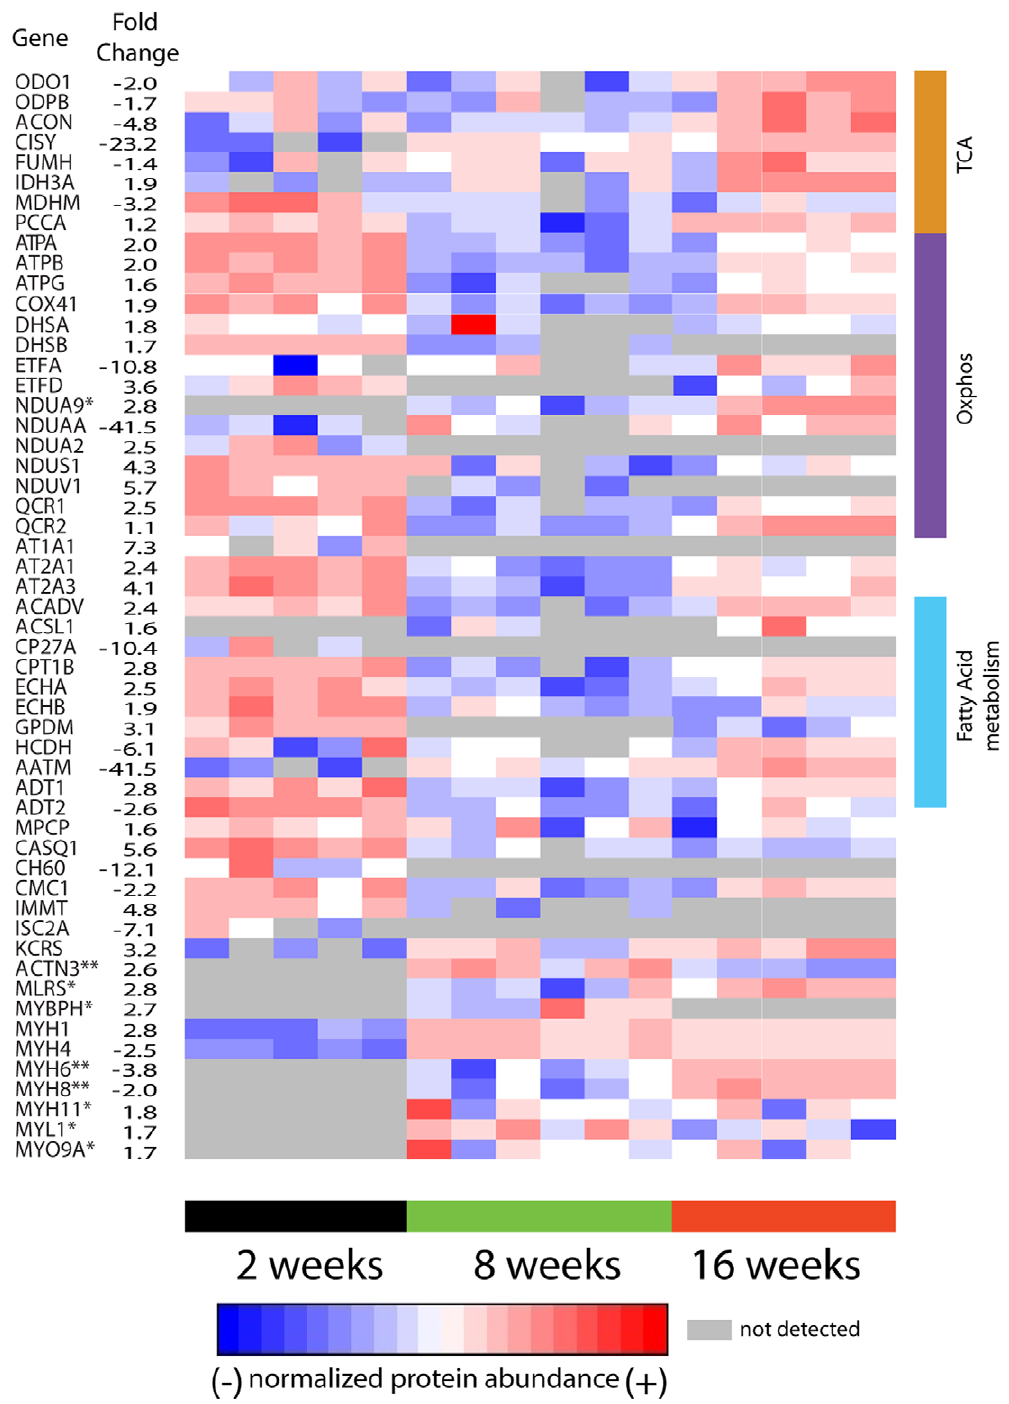
Figure 4. Diet induced alterations in protein abundance. Shown are proteins (rows) found to significantly differ in abundance (p , 0.05) comparing mice (columns) on HFD and SD for 2-, 8-, or 16-weeks. The average fold change between mice on SD and HFD is reported for the 2 week time interval unless otherwise indicated, * indicates fold change at 8 weeks, and ** indicates fold change at 16-weeks. A single outlier at 2- and 16- week time points was removed from the HFD group. doi:10.1371/journal.pone.0047996.g004 response to diet was followed by adaptation and return to near mice. Proteins associated with OXPHOS, the mitochondrial normal function. At 16-weeks on the HFD proteins with annotated respiratory chain, and fatty acid metabolism had the highest functions associated with OXPHOS, mitochondrial dysfunction, function at 2-weeks, the lowest function at 8-weeks, and moderate and fatty acid metabolism were elevated compared to SD fed function at 16-weeks. In contrast, TCA cycle proteins tended to